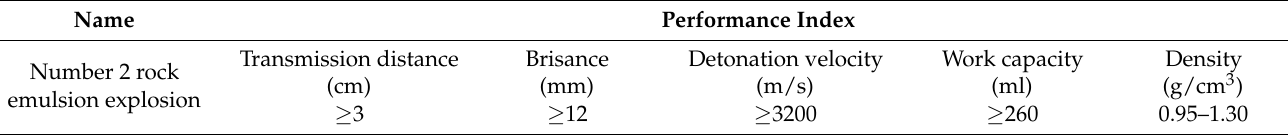
Table 3. Performance index of 2 rock emulsion